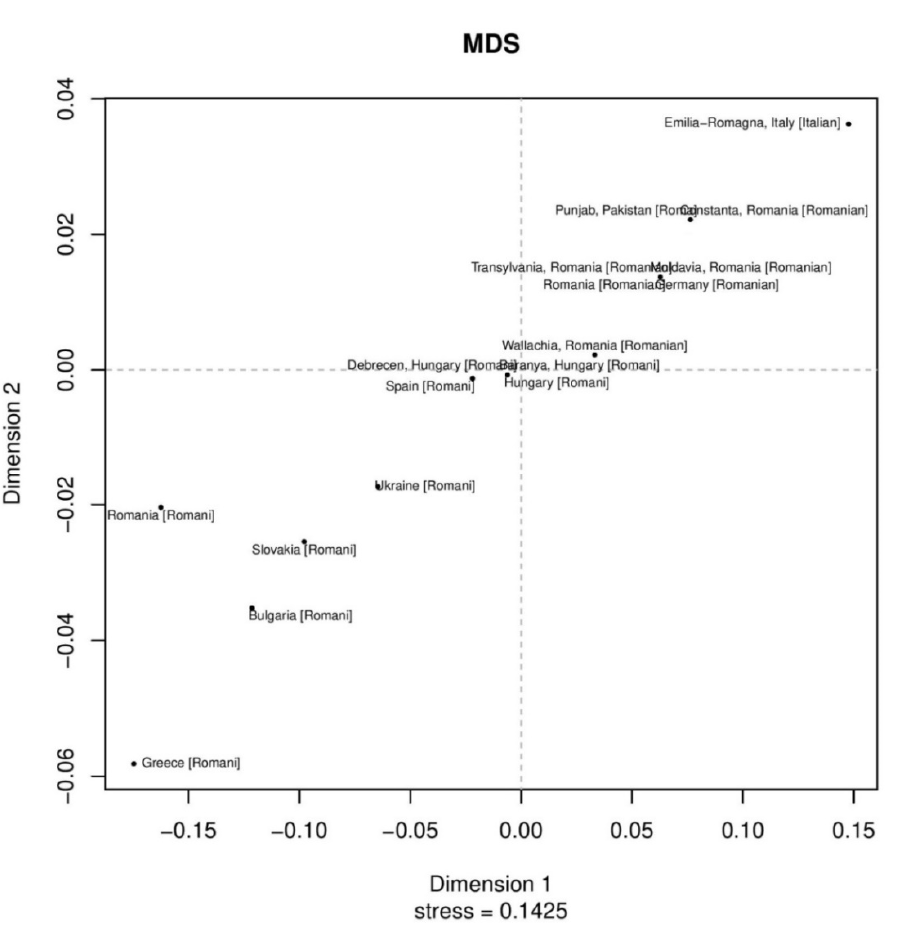
Figure 1. The two-dimensional plot from multi-dimensional scaling analysis of Rst values based on Yfiler haplotypes for 18 Roma populations.